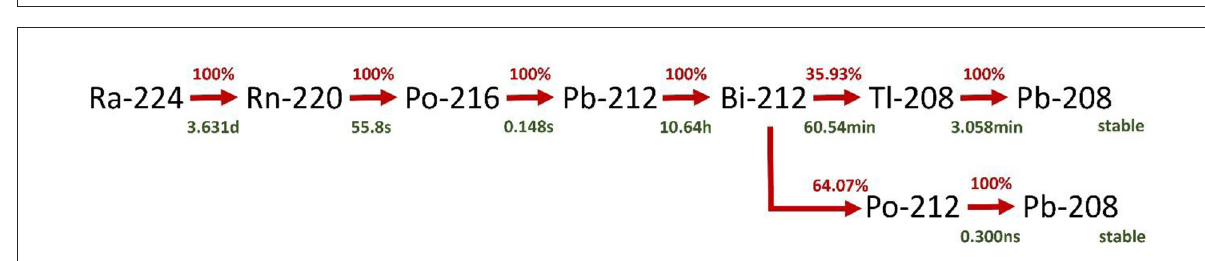
FIGURE1 Decay chain of 223 Ra. Decay products with branching ratios < 1% are omitted. The decay data were taken from http://www.nucleide.org/ Laraweb/index.php.